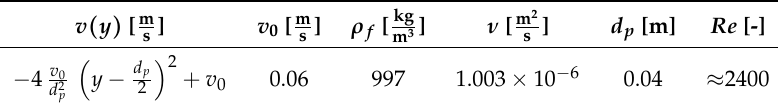
Table 3. Parameter for the simulation of a water flow inside a pipe.